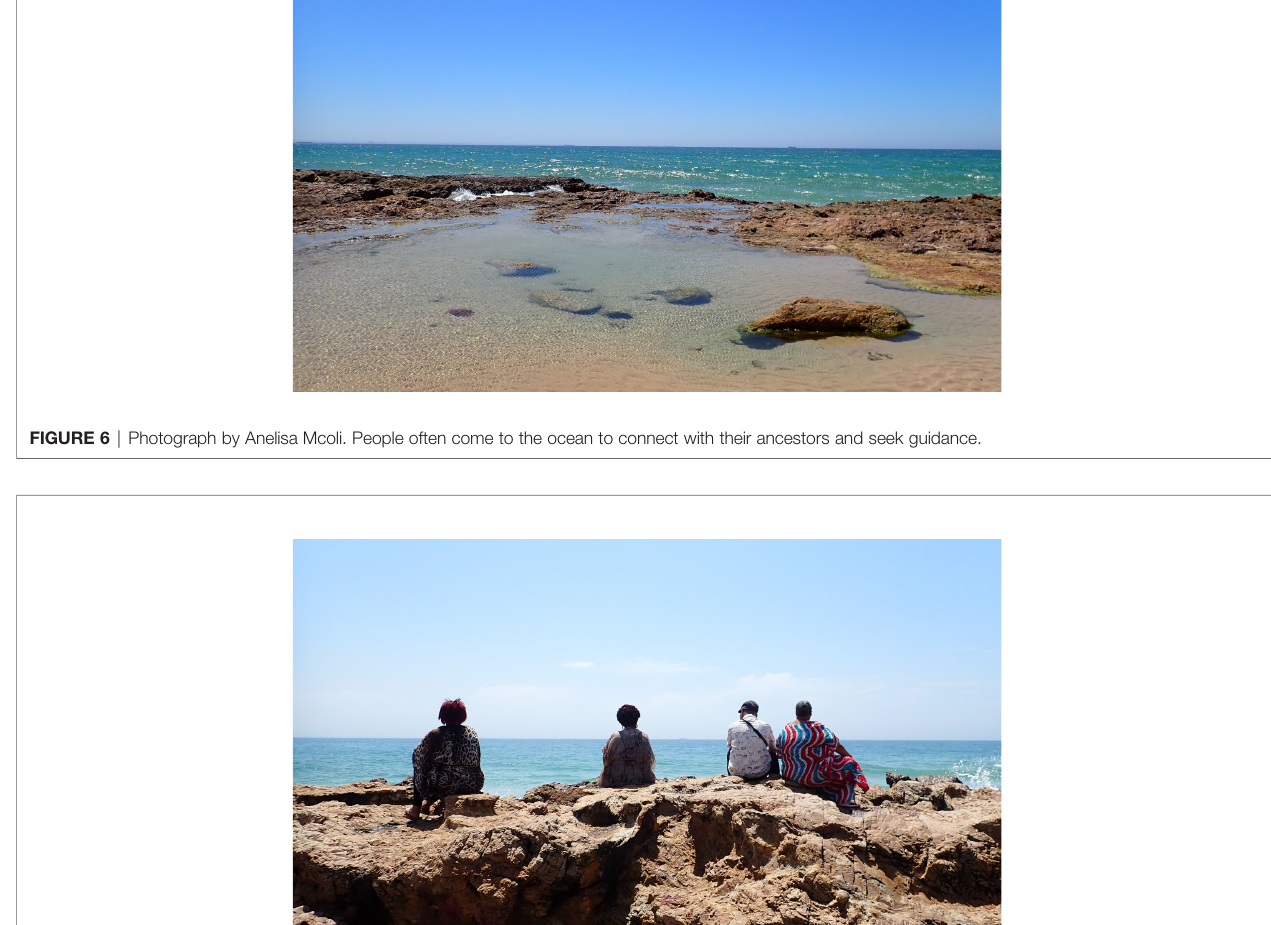
FIGURE 7 | Eileen Speelman, Haseline van Vught, Toetie Dow and Charlotte Bouah sitting on rocks at Hobie beach. Indigenous Khoisan people often come to the ocean to pray and to connect to their